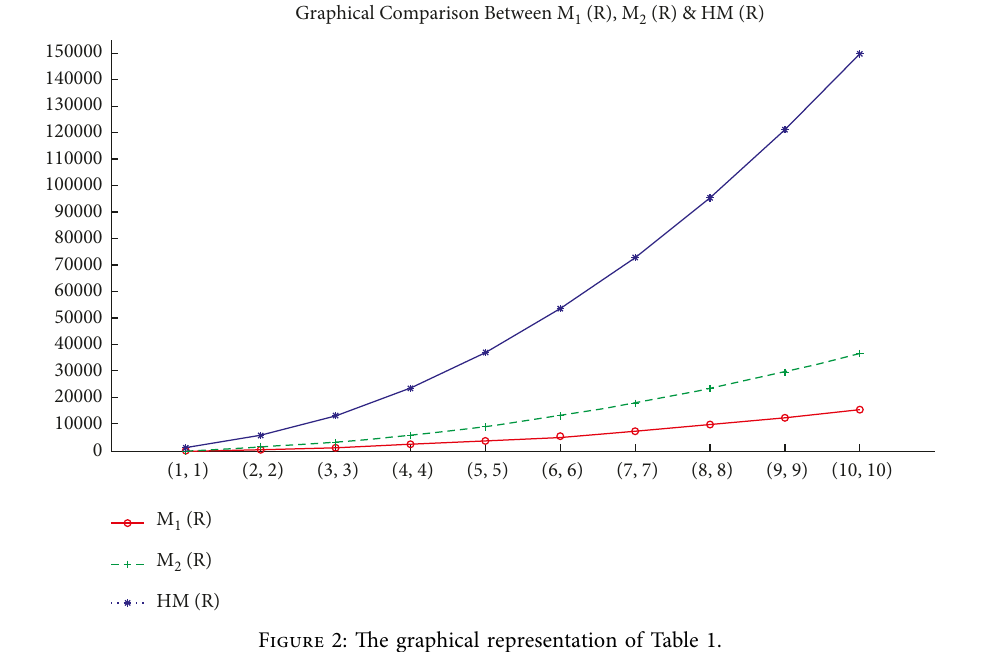
Figure 2: The graphical representation of Table 1. Table 2: Connection between M